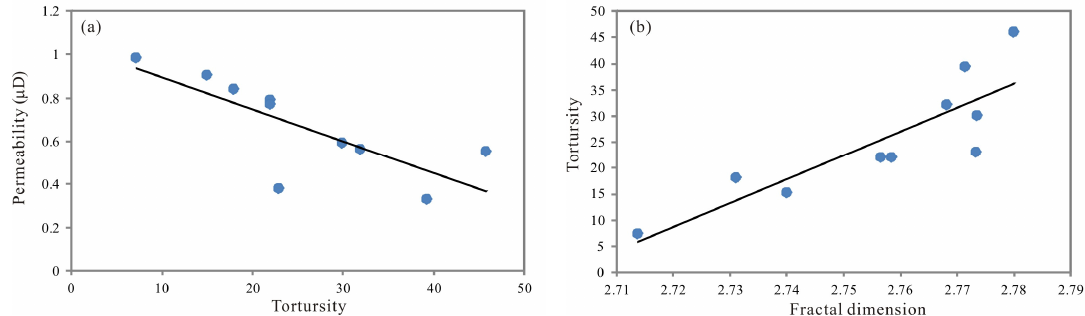
Figure 13. Relationship between tortuosity and permeability ( a ) and the relationship between fractal dimension and tortuosity ( b ).